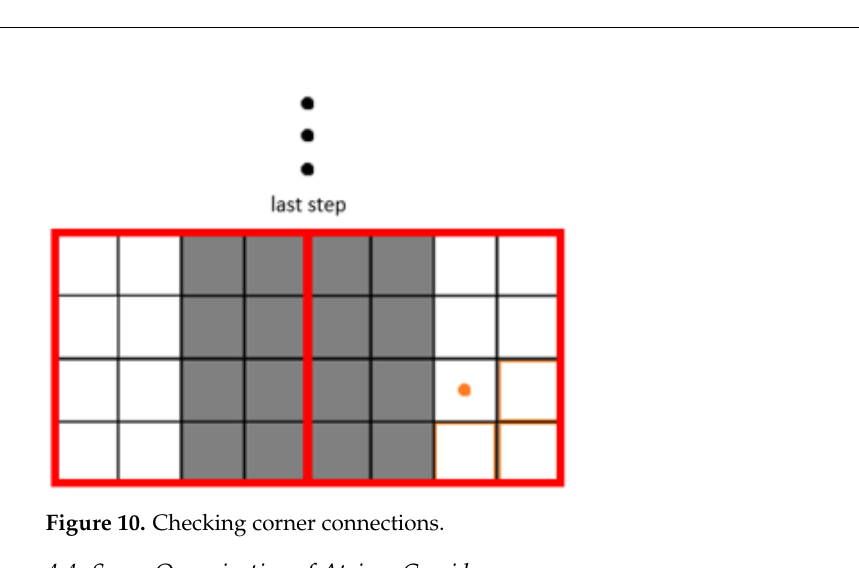
Figure 10. Checking corner connections.